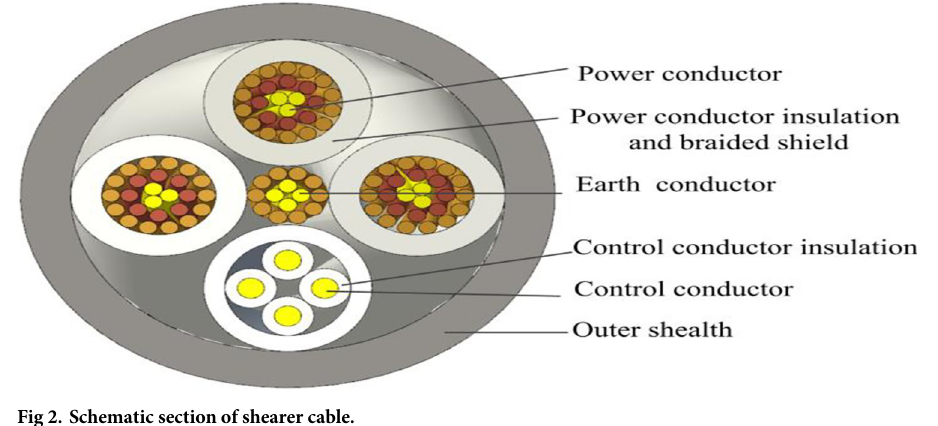
Fig 2. Schematic section of shearer cable.